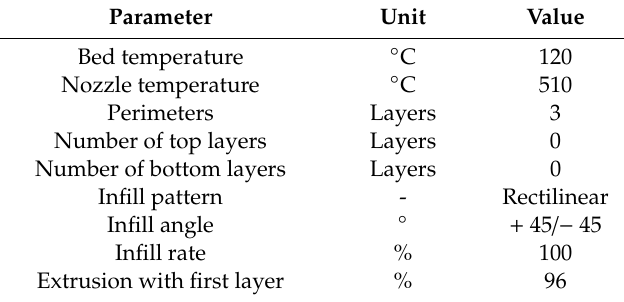
Table 3. Fixed process parameters.